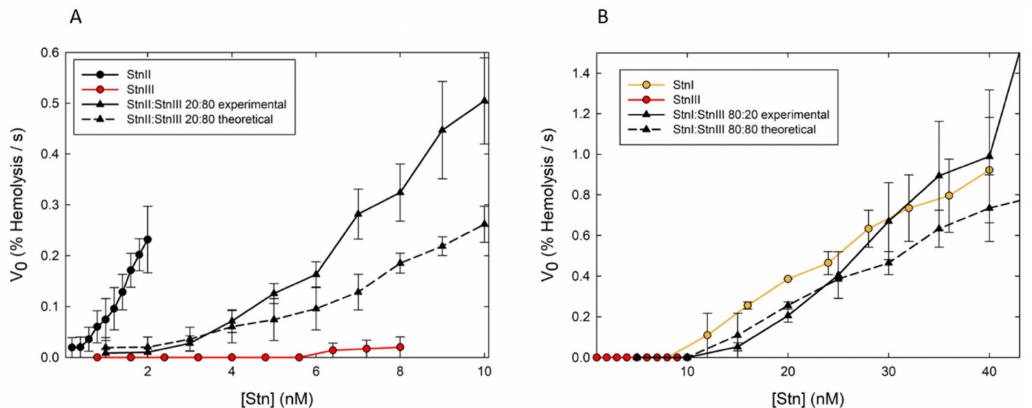
Figure 7. Synergic e ff ect on hemolysis. Maximum hemolytic rate values (expressed as percentage of hemolysis per second) are represented as function of protein concentration (in log scale). ( A ) StnII (black dots–solid line), StnIII (red dots–solid line), a StnII:StnIII (20:80) mixture (black triangles–solid line). ( B ) Same as in ( A ), but now the proteins employed were StnI (orange dots–solid line), StnIII (red dots–solid line), and StnI:StnIII (80:20) mixtures (black triangles–solid line). In both panels, the black triangles–dashed lines were obtained as the arithmetic addition of the rates obtained with the individual proteins for the real concentration of each one in the di ff erent mixtures employed. Values are average of n = 3 ± SEM. Hemolysis assays were performed in 96-multiwell plates at 25 ◦ C and exactly as described previously [118]. Briefly, erythrocytes from heparinized sheep blood were washed in 10 mM Tris buffer, pH 7.4, containing 145 mM NaCl, to a final A 655 of 0.5 when mixing equal volumes of the cell suspension and buffer. The hemolysis was followed as a decrease in A 655 after addition of the erythrocyte suspension to different final concentrations of protein. An Expert 96 microplate reader (Asys Hitech, GmbH, Eugendorf, Austria) was employed to measure the absorbance. The value obtained with 0.1% (w / v) Na 2 CO 3 was considered as 100%